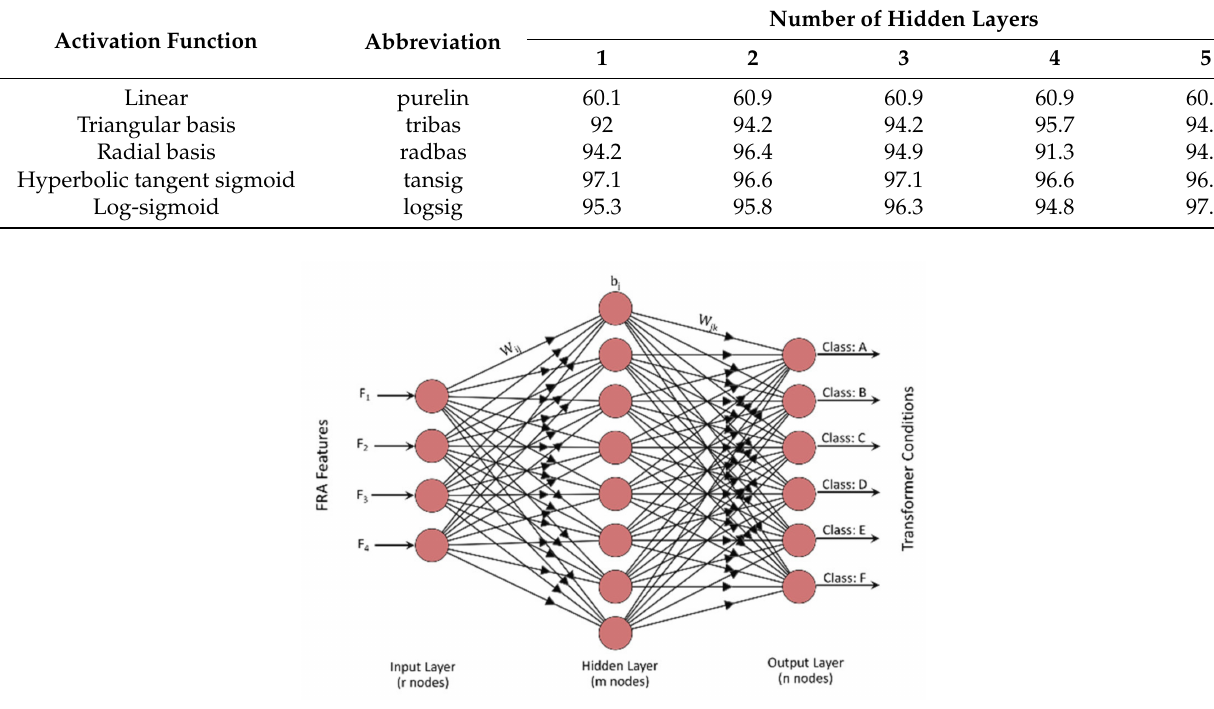
Figure 16. Three-layer structure of feedforward backpropagation